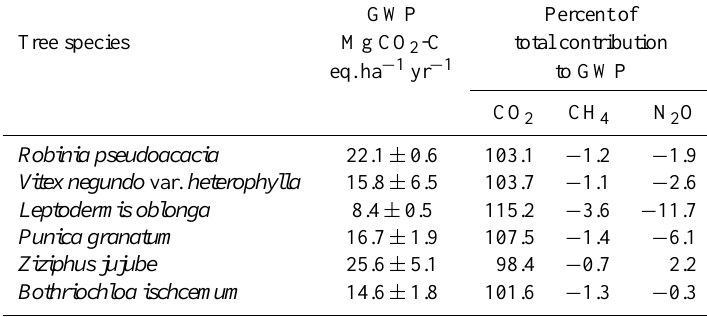
Table 7. Effect of tree species on global warming potential (GWP) and contribution of CO 2 , CH 4 , and N 2 O to